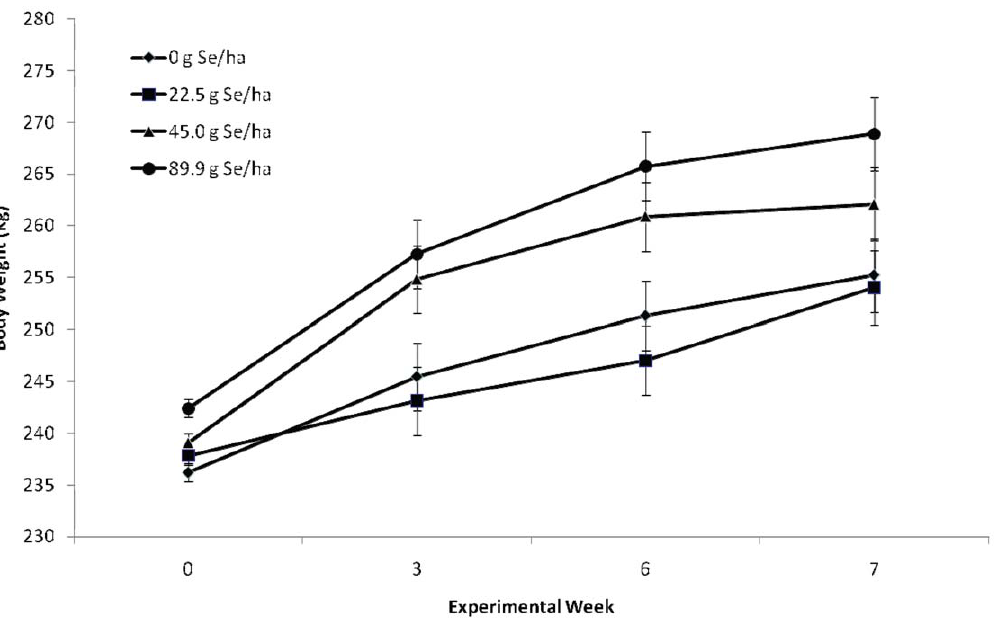
Figure 4. Comparison of block-adjusted BW (kg; mean 6 SEM) of weaned beef calves (primarily of Angus breeding and ranging in age from 4.5-to-6-mo) after consuming alfalfa hay grown in fields not fertilized with Se (0 g Se/ha), or harvested from fields fertilized with sodium-selenate at an application rate of 22.5, 45.0, or 89.9 g Se/ha for 7 wk (n=15 calves per group). Initial BW (baseline) ranged from 181 to 310 kg (239 6 3.6 kg, mean 6 SEM). Final BW (7-wk) ranged from 183 to 346 kg (260 6 4.1 kg, mean 6 SEM).